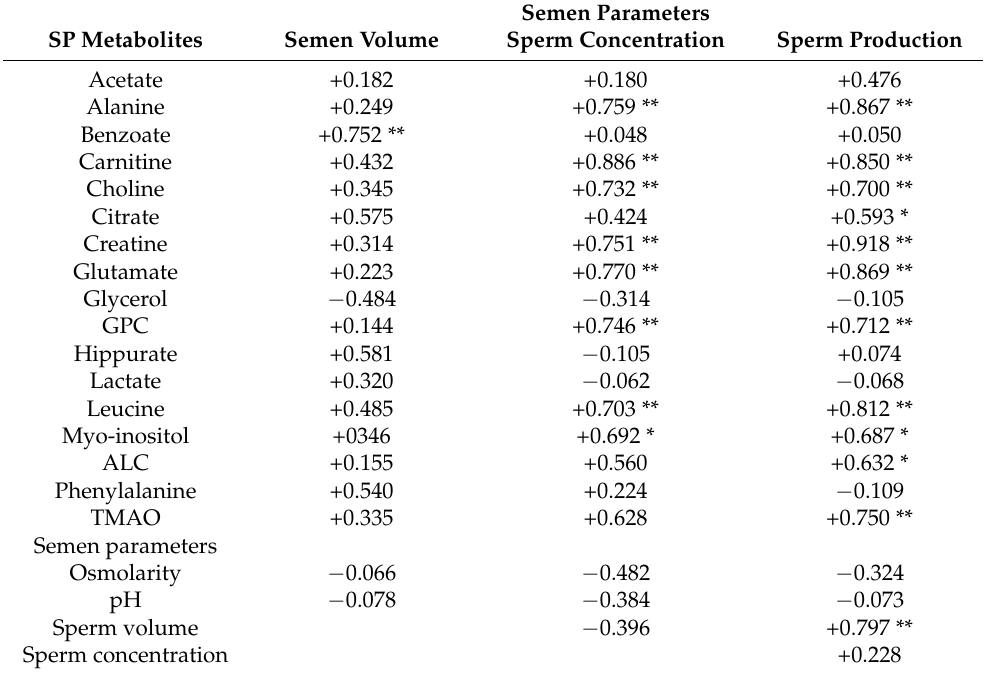
Table 4. Correlation coefficients (R) between seminal plasma metabolites and semen parameters in donkey stallions ( n =